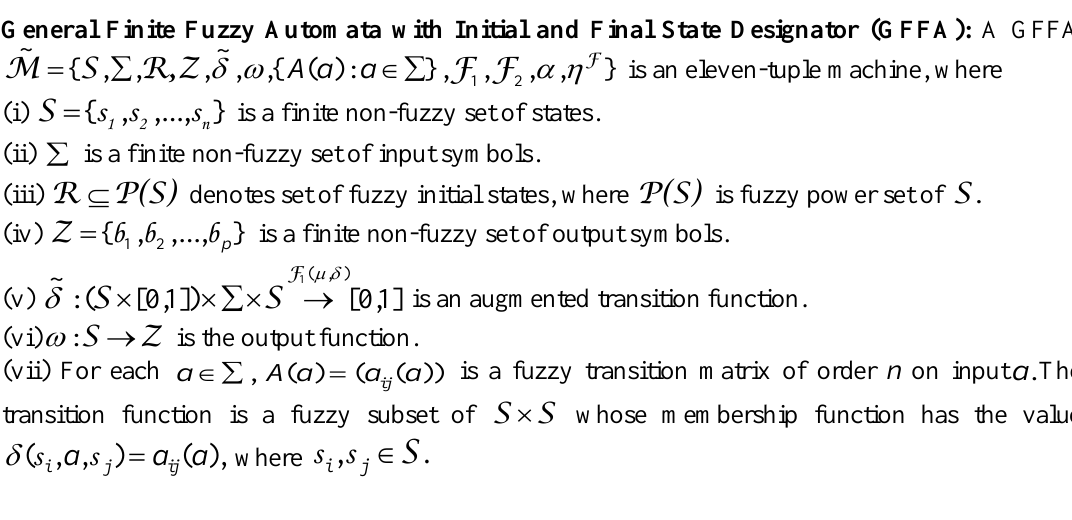
Algorithm 1 (Doostfatemeh and Kremer, 2005): For a